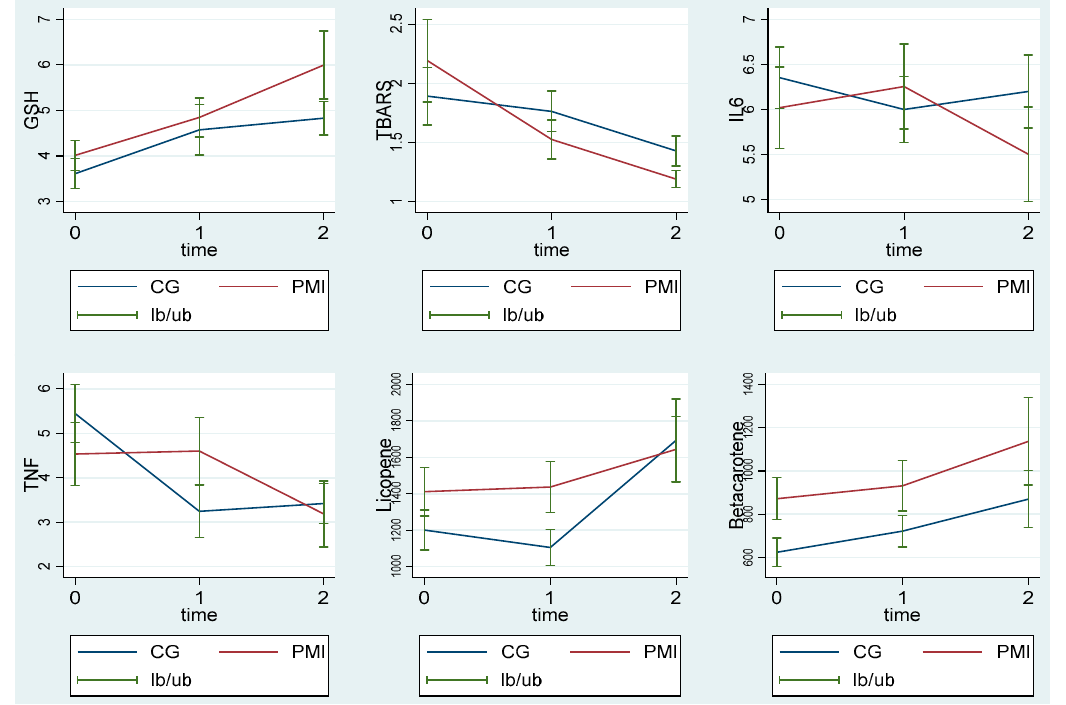
Figure 2. Plasma levels of glutathione, thiobarbituric acid reactive substances, interleukin 6, tumor necrosis factor α , and lycopene and β carotene in MI and CG measured at T0, T1, and T2. GSH: glutathione; TBARS: thiobarbituric acid reactive substances; IL6: interleukin 6; TNF α : tumor necrosis factor α ; PMI: psychotherapy with music intervention group; CG: treatment as usual group. T0: baseline; T1: at the end of radiotherapy; T2: three months after the end of radiotherapy. The graphs show the mean and the standard error.